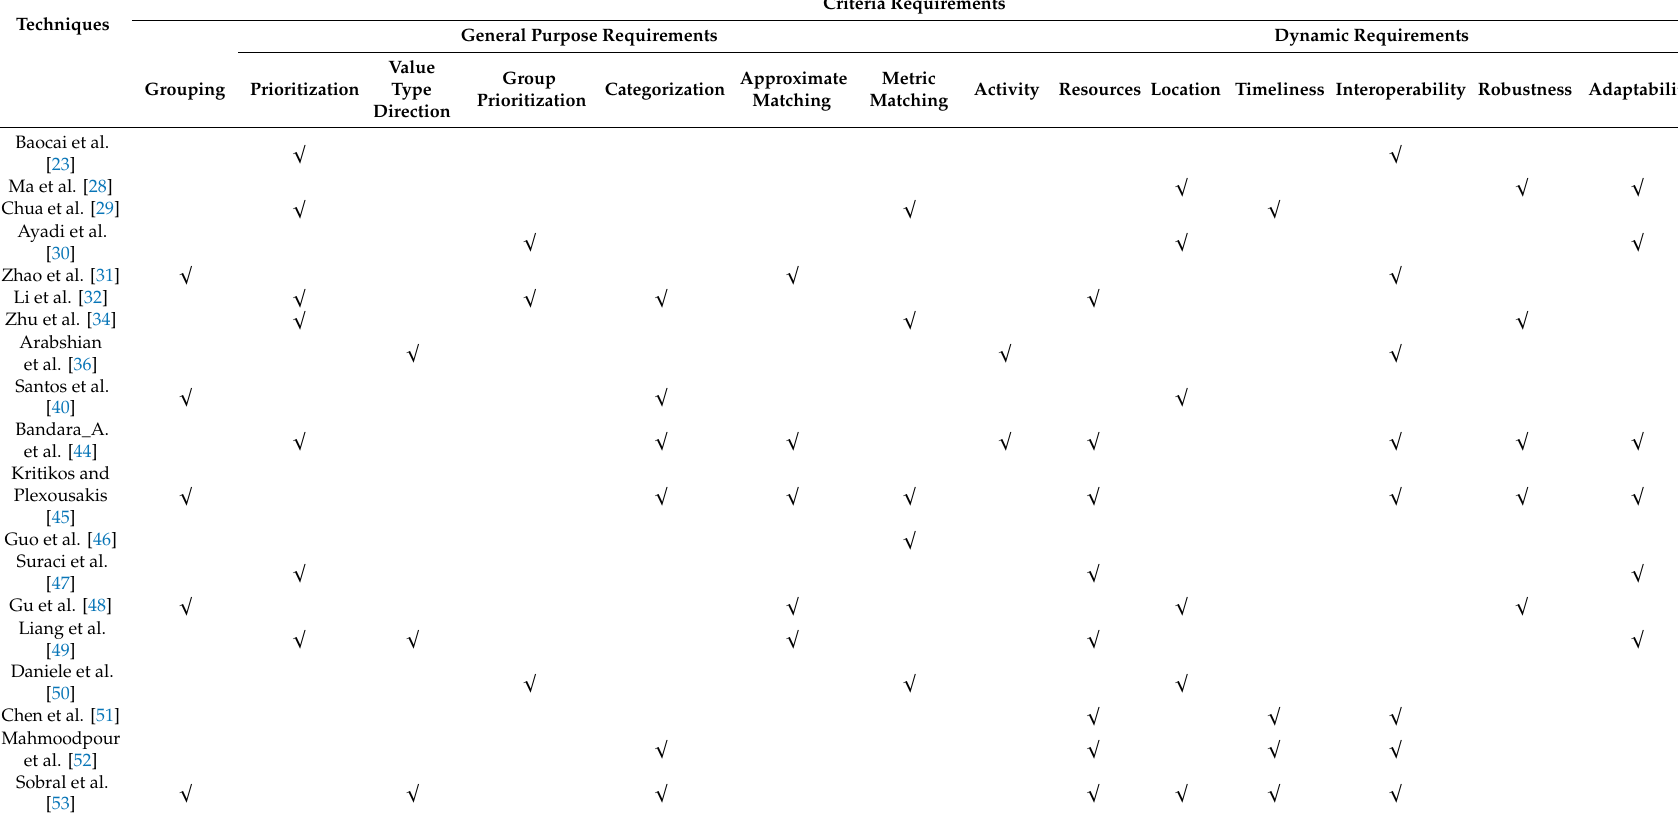
Table 3. Comparison among existing techniques for service